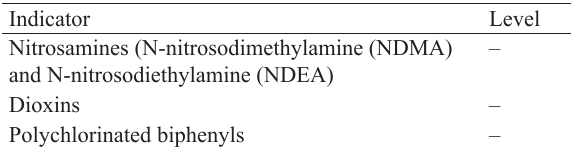
Table 3 Hygienic indicators of carp